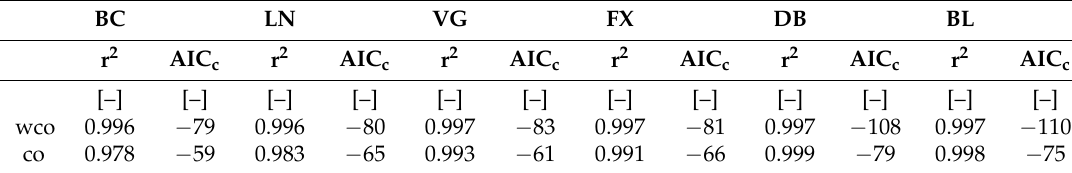
Table 12. Coefficients of determination (r 2 ) and AIC criterions (AIC c ) of the boulder marl without compost (wco) and with compost (co): BC model [18], VG model [9], FX model [19], LN model [20], DB model [21], and BL model